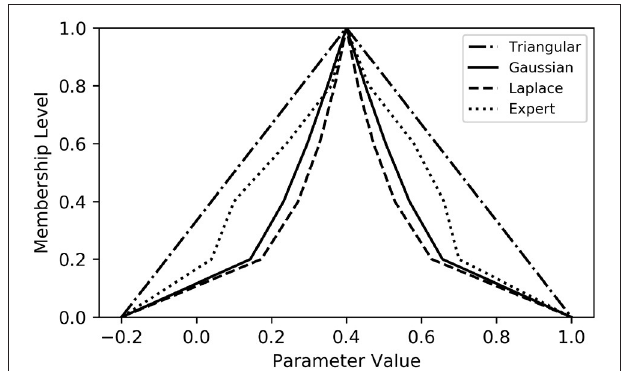
FIGURE 1 | Examples of possible shapes of the membership function for a fuzzy number describing possible values of an arbitrary parameter. Functions for a triangular (dash-dotted), transformed Gaussian (solid), transformed Laplace (dashed), and expert knowledge-informed (dotted) fuzzy number are shown. The transformed membership functions are derived using a crisp value µ K 0.4, and standard deviation σ 0.2. All functions have a support width = = of 3 σ